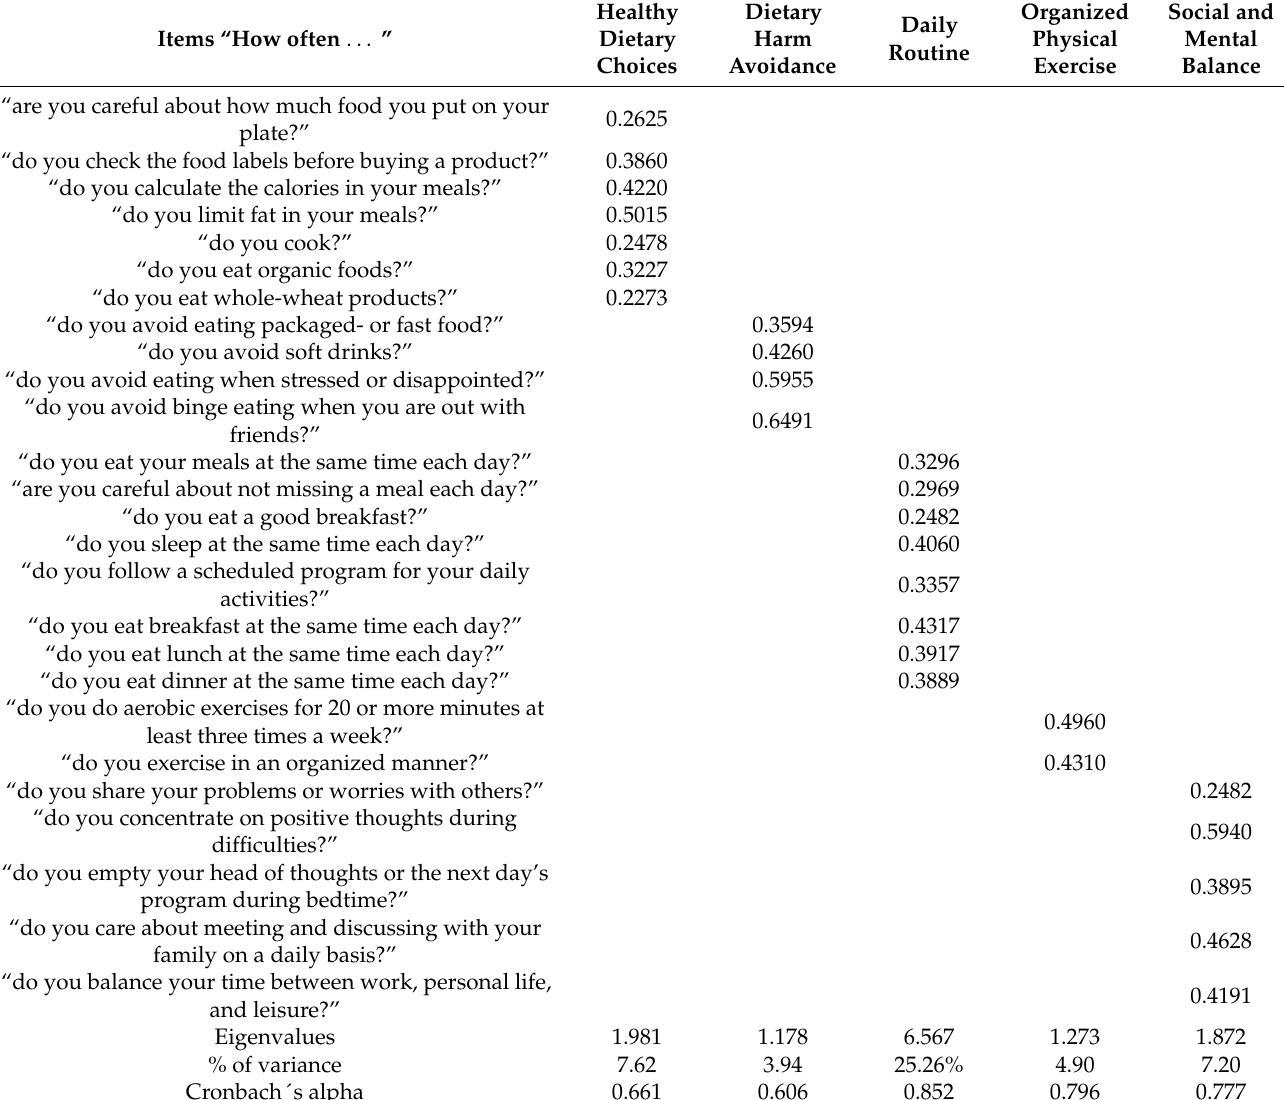
Table 2. Rotated factor loading of the principal component analysis (PCA) for 26 health-related lifestyle habits (N = 2433). Items “How often . . . ”